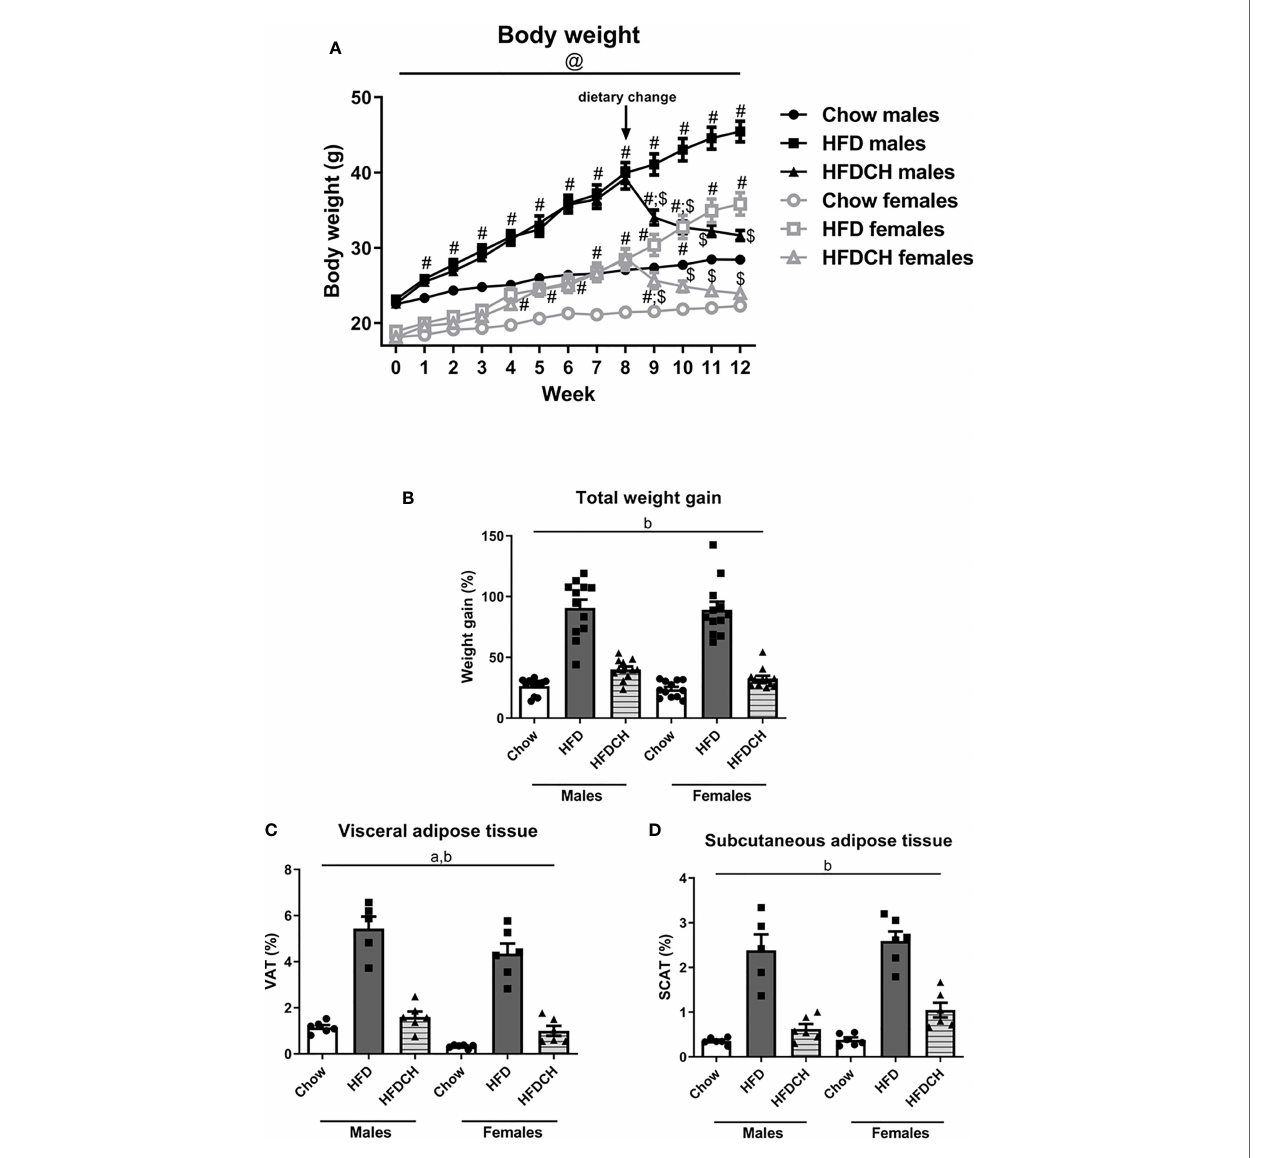
FIGURE 1 | Weekly body weight progression (A) and total weight gain (B) throughout the study, as well as the percentage of visceral (C) and subcutaneous (D) adipose tissue in male and female mice exposed to a high-fat diet (HFD) or to a chow diet for 12 weeks or receiving HFD for 8 weeks and then changed to chow for the remaining 4 weeks of the study (HFDCH). a: effect of the sex. b: effect of the diet. #: different from chow in the same sex, $: different from HFD in the same sex, @, different between sexes on the same diet. n =